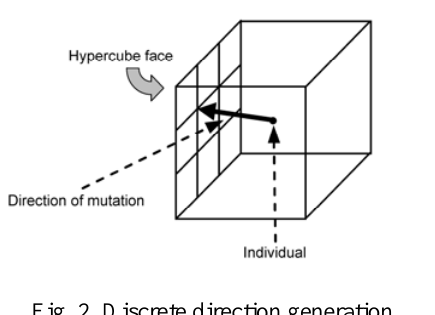
Fig. 2. Discrete direction